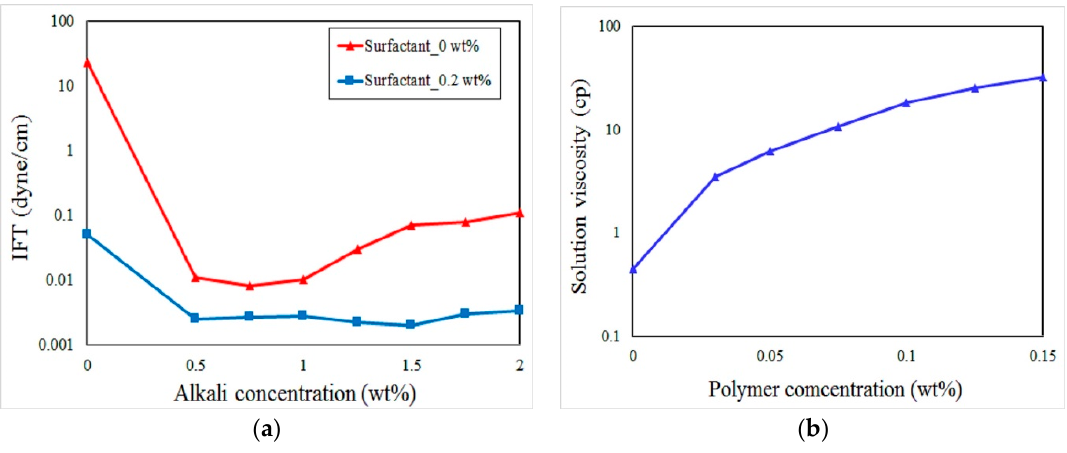
Figure 2. Chemical properties used for simulation: ( a ) IFT relationship; ( b ) Viscosity of polymer solution without salinity. Table 2. Chemical injection design for the simulation and the real project in Gudong field [22].